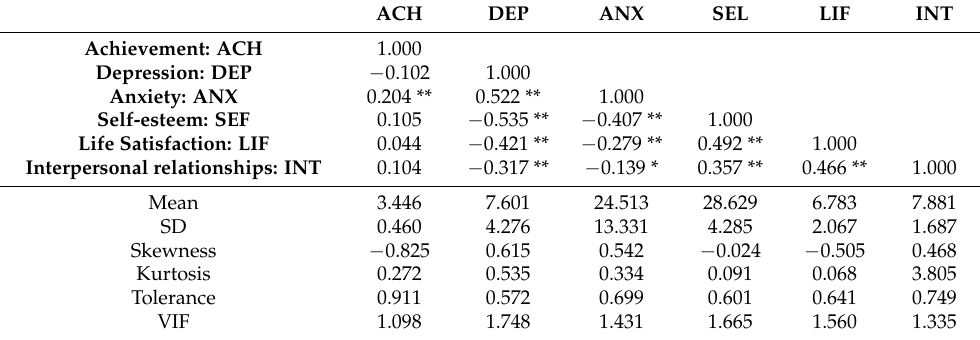
Table 3. Variables influencing depression and learning achievement of high school